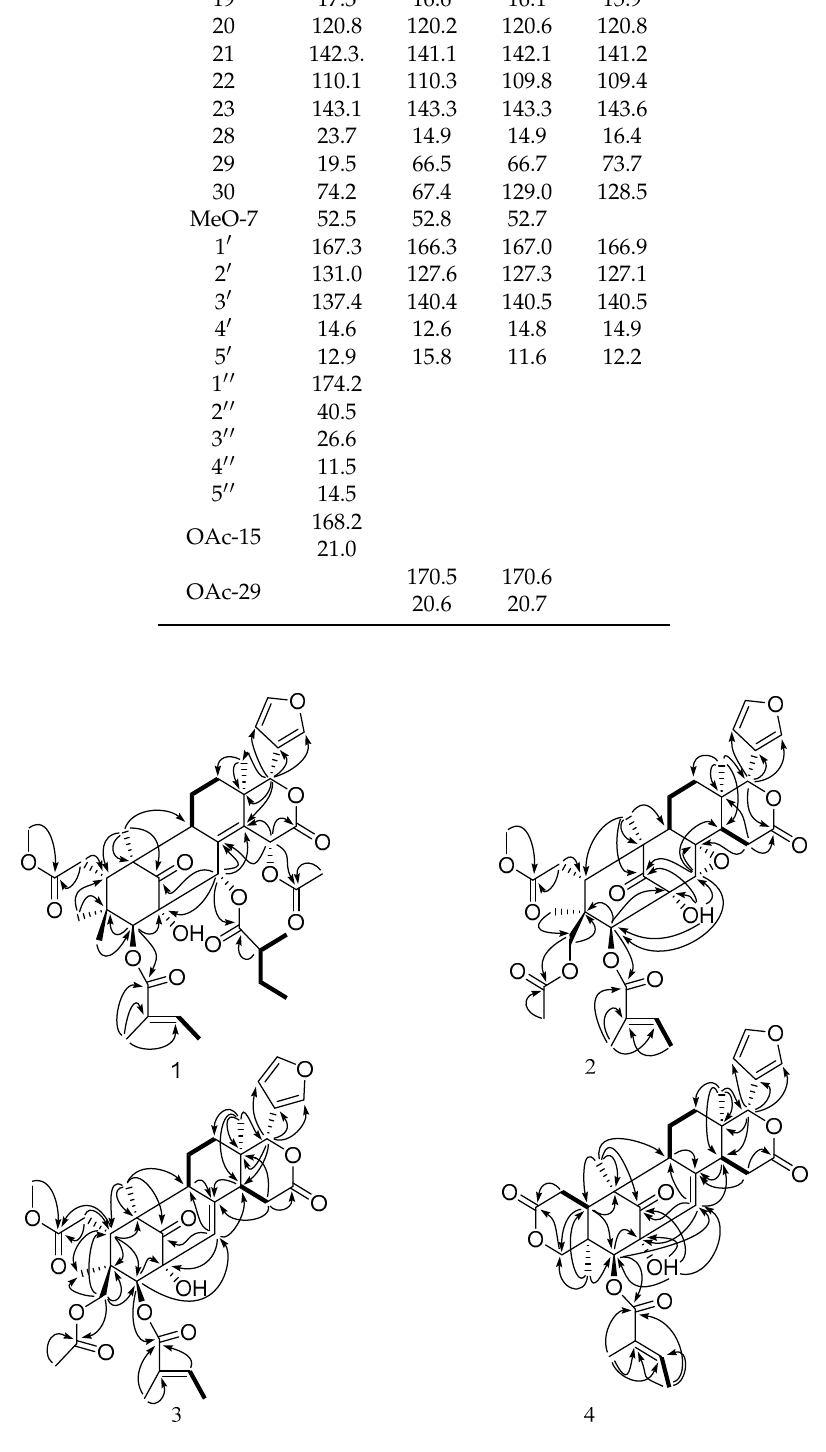
Figure 2 . Selected 1 H- 1 H COSY and HMBC correlations of 1 – 4 . Figure 2. Selected 1 H- 1 H COSY and HMBC correlations of 1 – 4